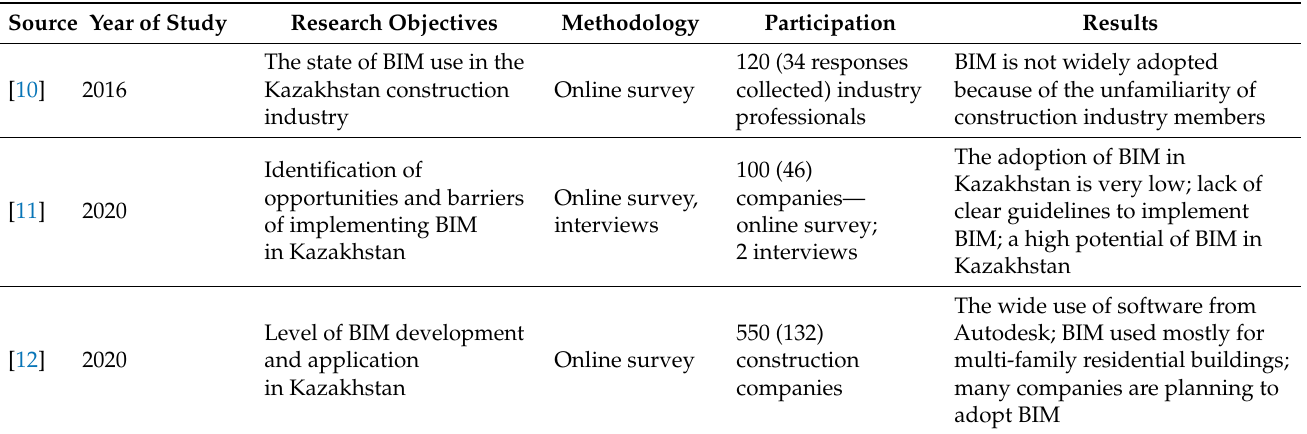
Table 2. Conducted research on BIM technology in Kazakhstan.